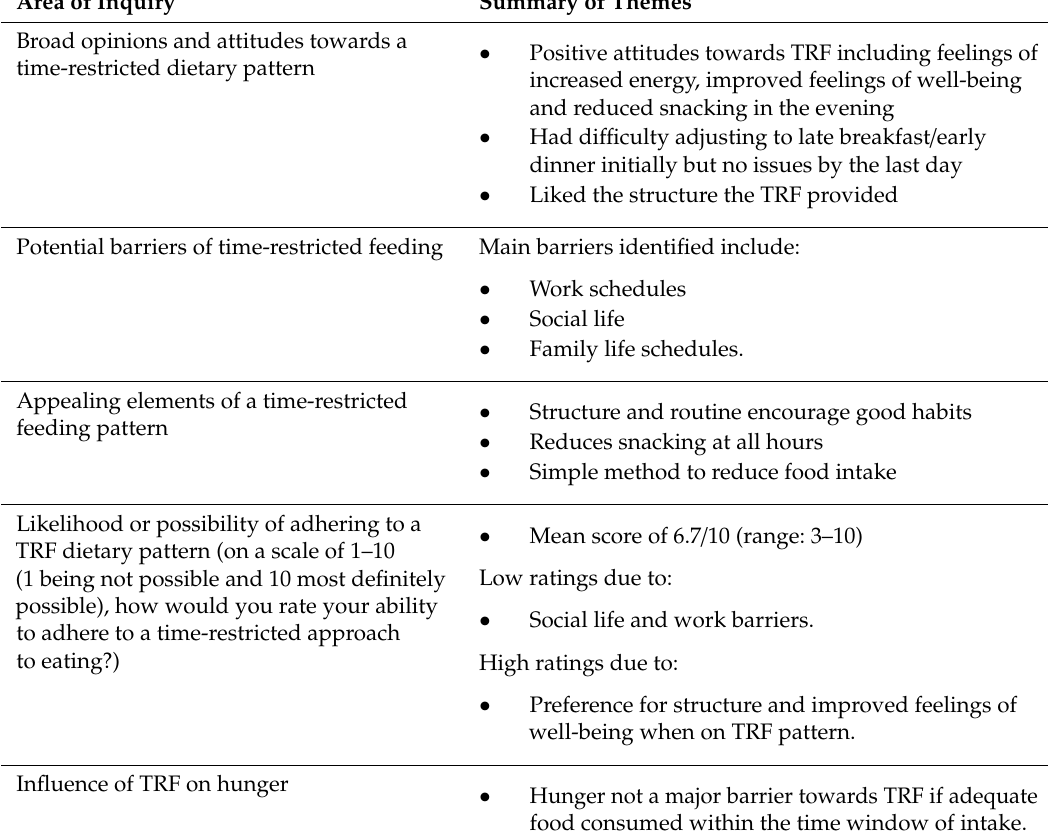
Table 3. Summary of themes from qualitative participant